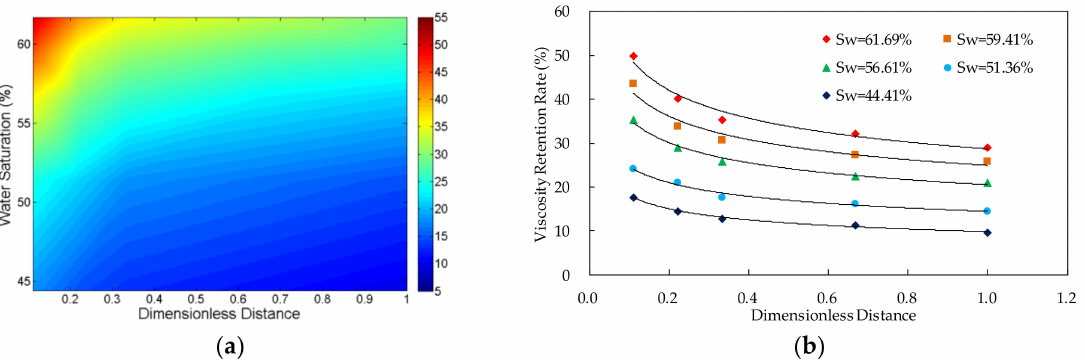
Figure 3. The relationship between viscosity retention rate of polymer solution, dimensionless distance and water saturation in the experiment VV-1 in which the polymer concentration is 500 mg/L. ( a ) Contour map of viscosity retention rate; and ( b ) scatter plot of viscosity retention